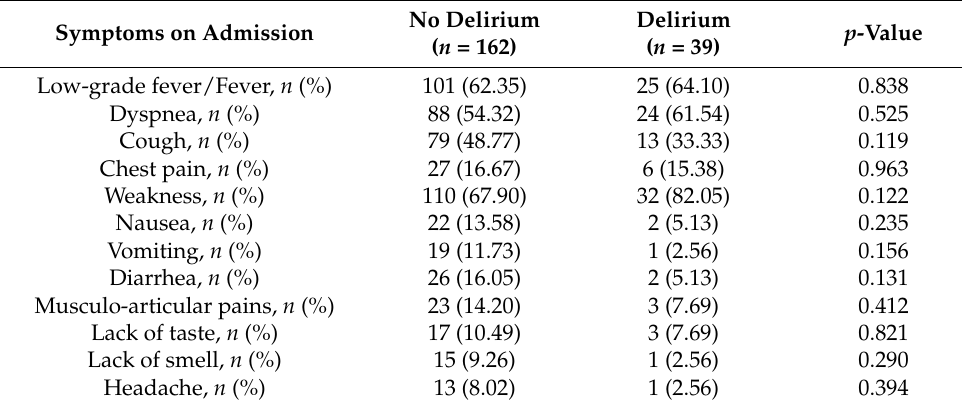
Table 3. Coronavirus-related symptoms on admission to the